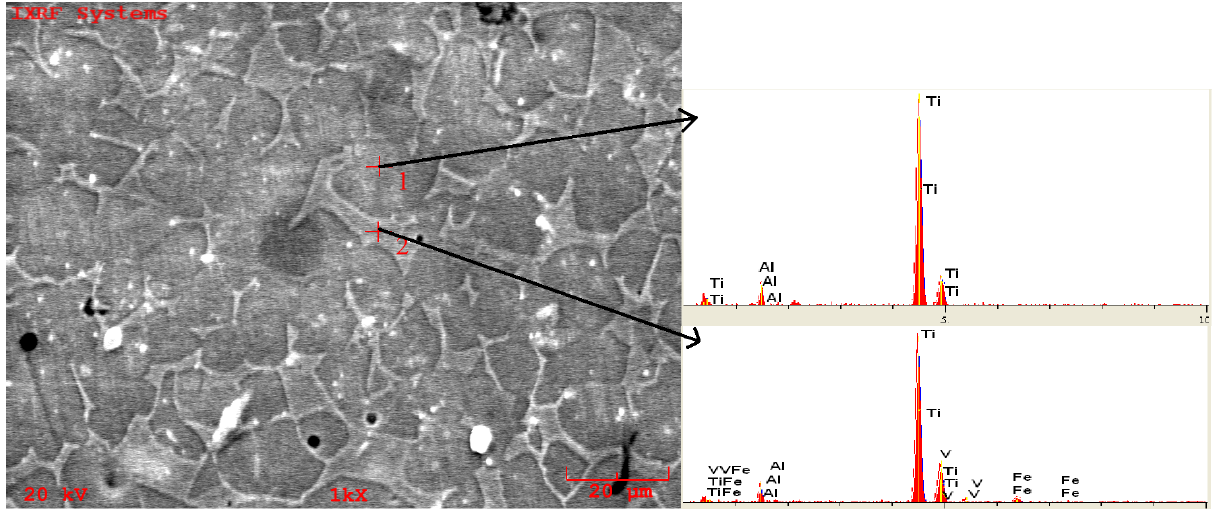
Figure 3. SEM images taken from Ti6Al4V alloy and EDS